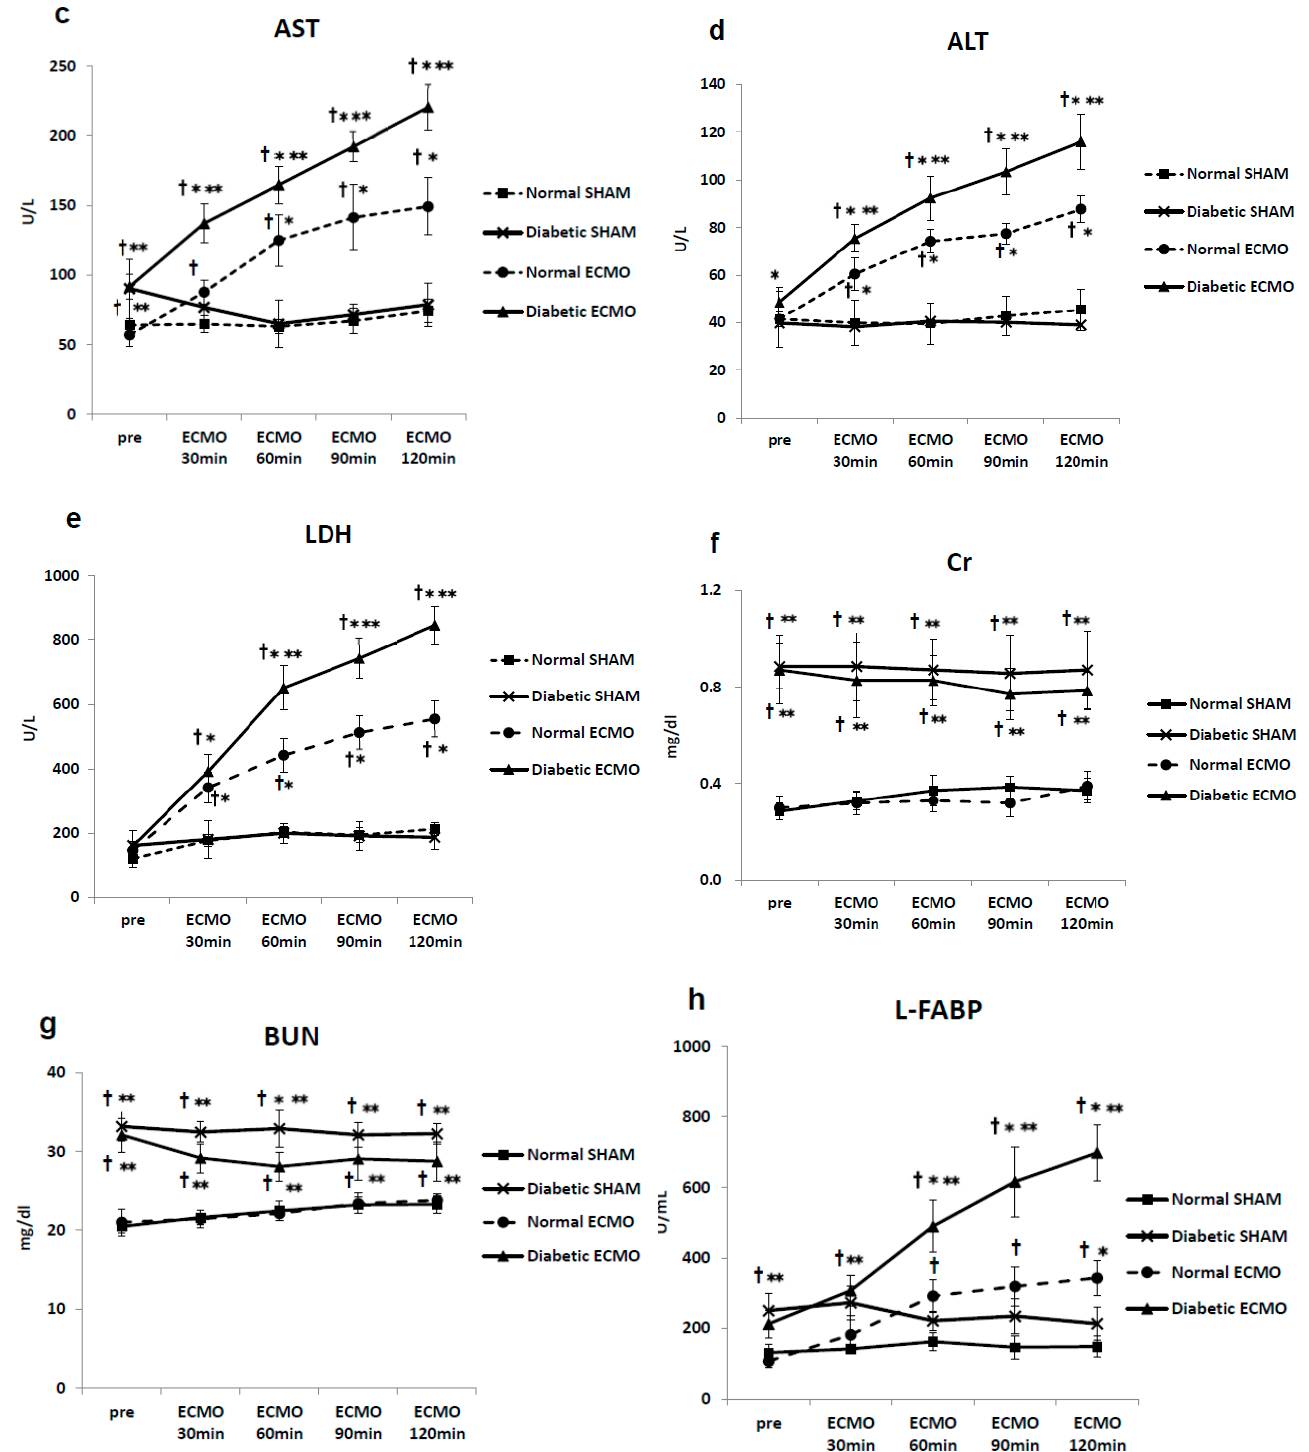
Figure 3. Plasma tumor necrosis factor (TNF)- α ( a ), interleukin (IL)-6 ( b ), aspartate aminotransferase (AST) ( c ), aminotransferase (ALT) ( d ), lactate dehydrogenase (LDH) ( e ), creatinine (Cr) ( f ), blood urea nitrogen (BUN) ( g ), and liver-type fatty acid binding protein (L-FABP) ( h ). † p < 0.05 versus normal SHAM group at the same time point, * p < 0.05 versus diabetic SHAM group at the same time point, ** p < 0.05 versus normal cardiopulmonary bypass group at the same time point.